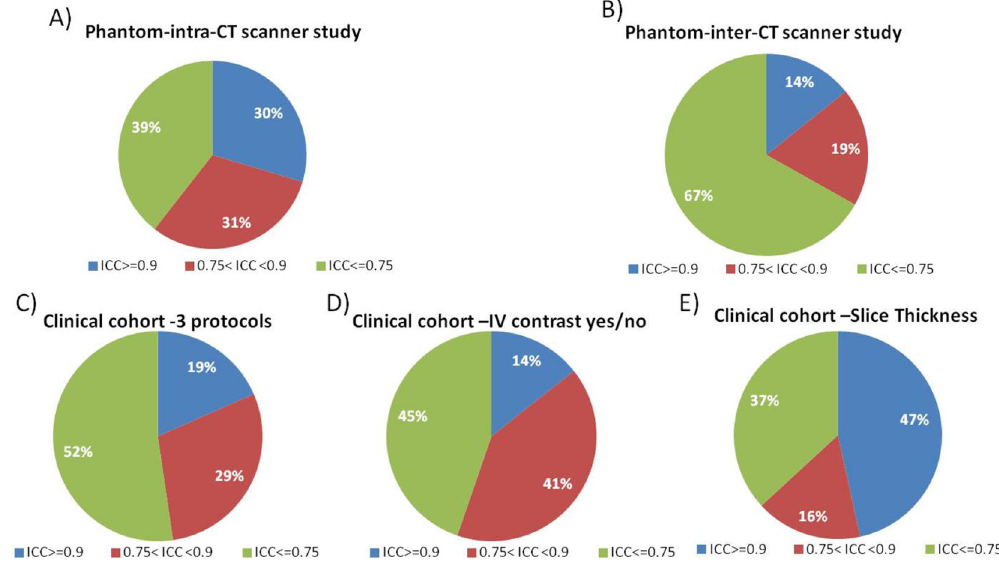
Figure 2. Results of the reproducibility experiments: ( A ) intra-scanner experiment using the phantom. By taking the median of all ICCs computed on the three scanners; ( B ) inter-scanner experiment using the phantom across all three scanners; ( C ) stability of radiomic features with respect to three different clinical protocols in the clinical study; ( D ) impact of IV (intravenous) contrast medium presence (WBCECT2)/ absence (NCCTT2) and difference in current (WBCECT2:Auto mA = 100–200; NCCTT2: fixed mA = 300 ) in the clinical study, and E) impact of slice thickness (2 vs 5 mm) in the human study. Three different levels of reproducibility are defined: good (ICC ≥ 0.9), medium (0.75 < ICC < 0.9), and poor (ICC ≤ 0.75).